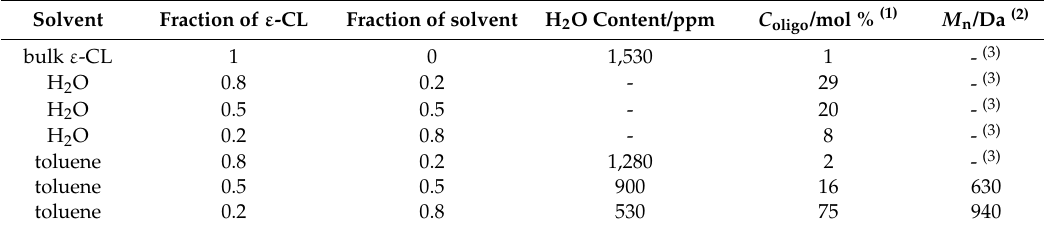
Table 1. CaLB catalyzed ROP of ε -CL in bulk, water and toluene with varying ε -CL concentrations; conversion to oligomers and their molecular weights.